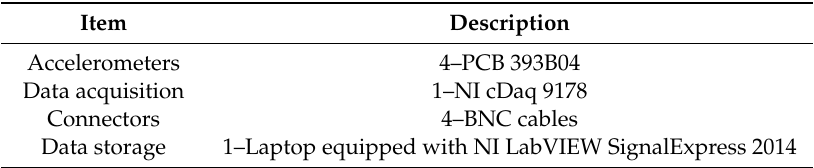
Figure2. Uniaxialaccelerometerlayout. ThedashedlinesrepresentGLTbeamsandgirders. Dimensions Figure 2. Uniaxial accelerometer layout. The dashed lines represent GLT beams and girders. refer to the center of the accelerometers. Dimensions refer to the center of the accelerometers. Table 2. Description of vibrational test equipment